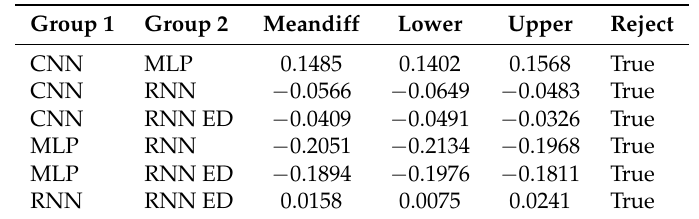
Figure 5. Distribution of the sum R 2 using MLP for the test and validation datasets and linear regression for both results. Table 5. Distribution comparison between the experiment using Tukey’s honestly significant difference test, Family wise error rate FWER = 0.05, after the ANOVA test of a F -value of 2.655 and a p -value of